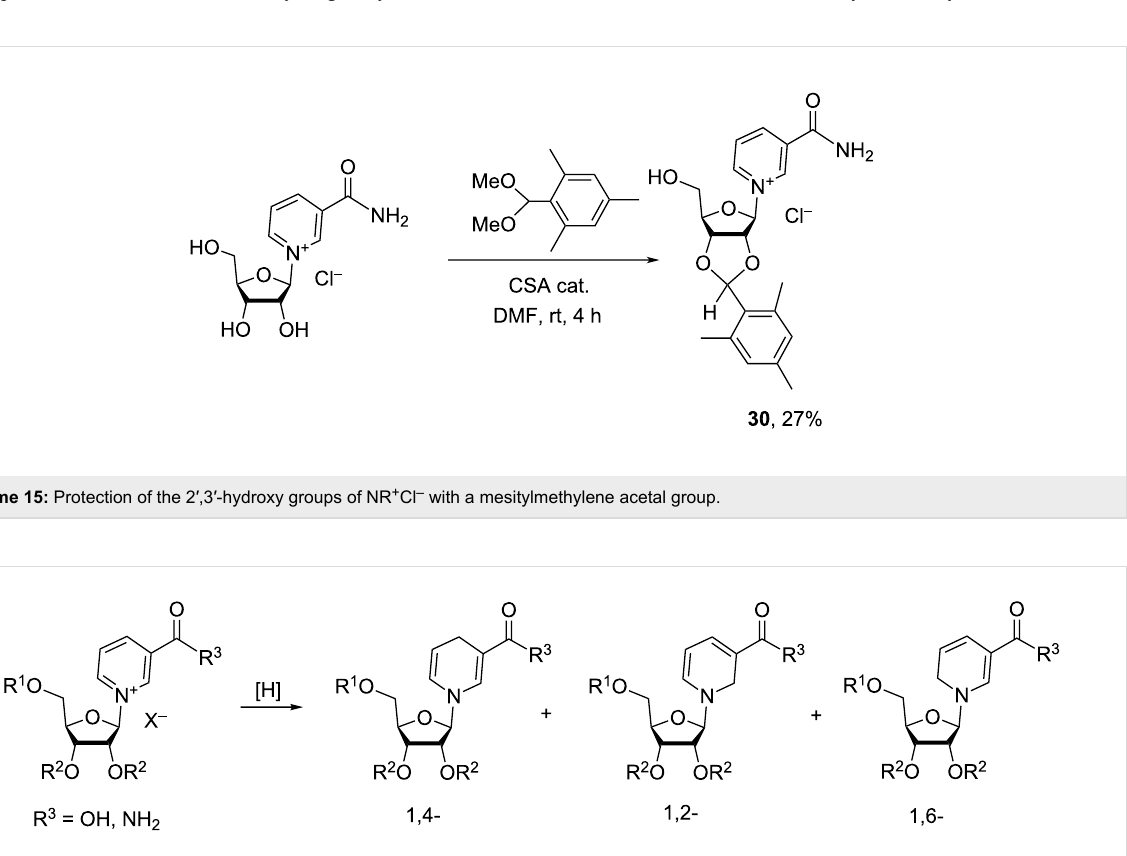
(4-Me-NR + Cl − ) in dry DMF in the presence of a 6 M HCl dioxane solution (almost equimolar amount relative to 4-Me- NR + Cl − ) to give the corresponding acetonide in 88%